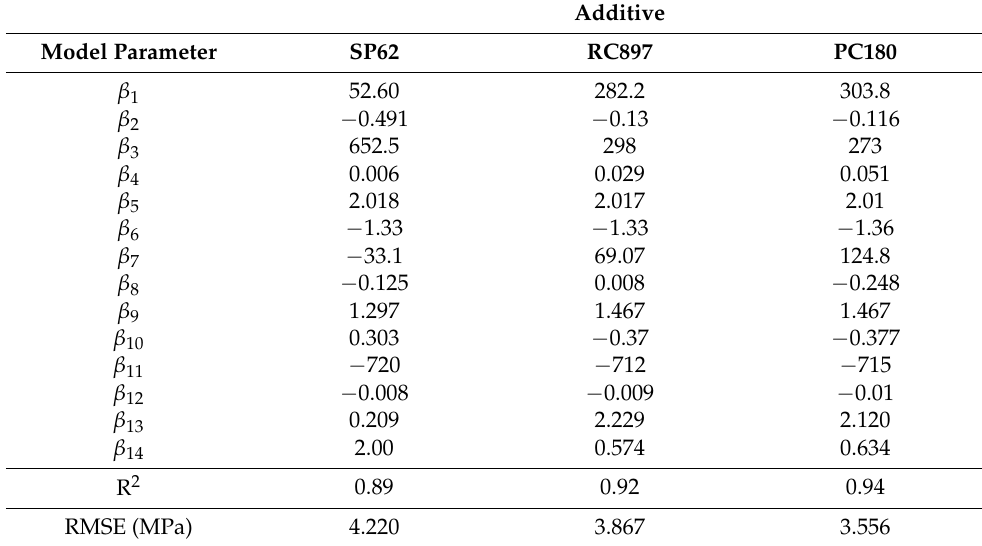
Table 5. NLR model paramters.